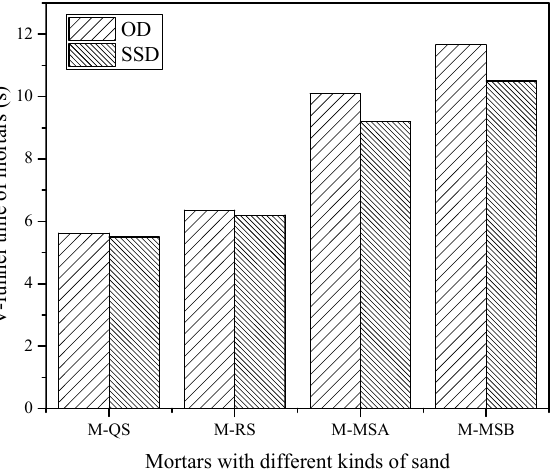
Mortars with different kinds of sand Figure 6. V-funnel times of mortars with four kinds of sands. The differences in slump flow and V-funnel time between two different moisture conditions were related to the water absorption of sands. The water absorption of different types of sand increased from 0.35% to 2.30%. Some water was absorbed by sand in OD conditions to reach SSD conditions; therefore, the effective V W /V C decreased, which led to the decrease in slump flow and the increase in V-funnel time. In other words, the decrease in effective V W /V C led to the increase in yield stress and the plastic viscosity of mortars. thickness had a major effect on the rheology of the mortar [61]. It should be noted that the density and shape parameters of the four kinds of sand were also different, which also affected the rheological properties of mortars. 4.2. Effect of Sand Density on Mortar Rheological Properties Due to the difference in mass and density of sand in each group of mortar, the rela- tionship between the rheology of mortar and the volume ratio of paste and sand ( V paste / V sand ) is discussed. Based on the definition of V paste / V sand , the V paste / V sand is directly pro- portional to the density of sand. The density of QS was much higher than other sands, the volume ratio of paste and sand is the largest. However, there was no obvious linear rela- tionship between slump flow or V-funnel time and V paste / V sand , as shown in Figure 7a,b. This is because of the nature of the RS particles. Mortar using RS had a larger slump flow and smaller V-funnel time as a result of the particles of RS being nearly spherical. When the particle shape of sand is similar, the rheological properties of mortar are positively related to the densities of sand. When the densities of sands are similar, the rheological properties of mortars are related to sand particle shape. The closer the shape of the sand particle becomes to a spherical form, the larger the slump flow of mortar and the smaller the V-funnel time. Considering that it is difficult to distinguish the influence of sand shape and density on mortar rheology, both of them were considered in this study.